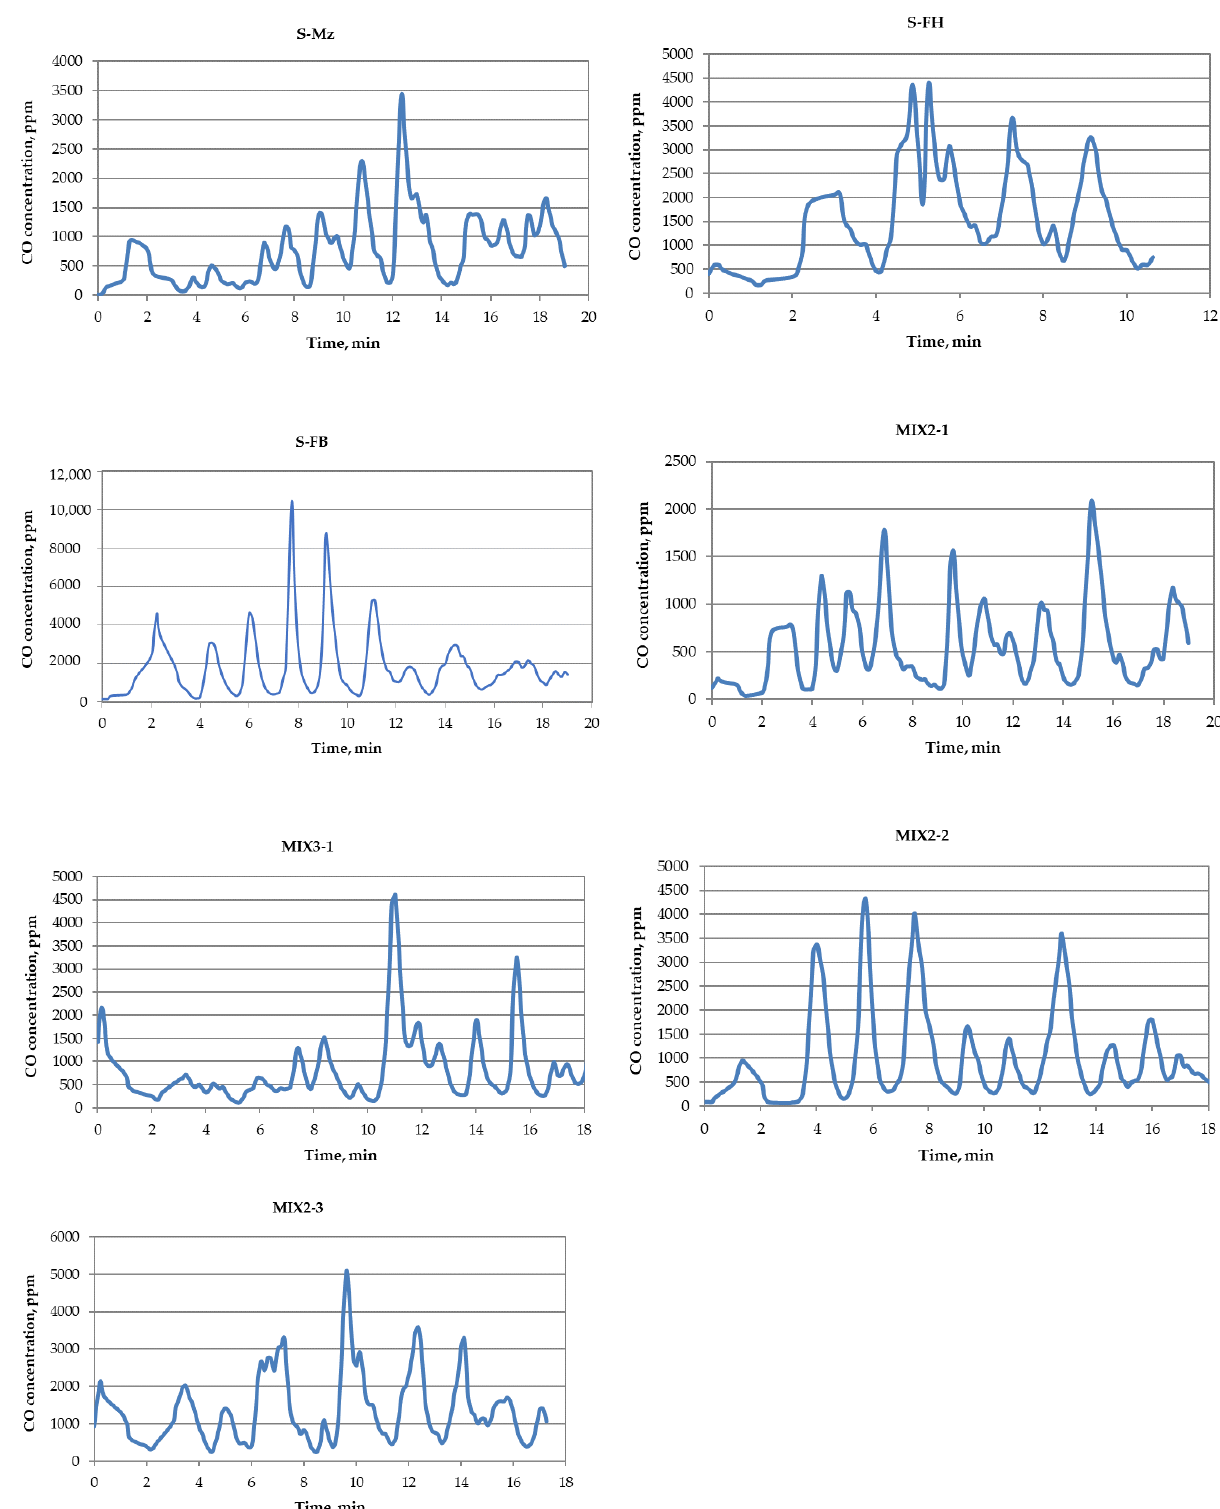
Figure 5. CO concentrations during combustion of plant biomass pellets.